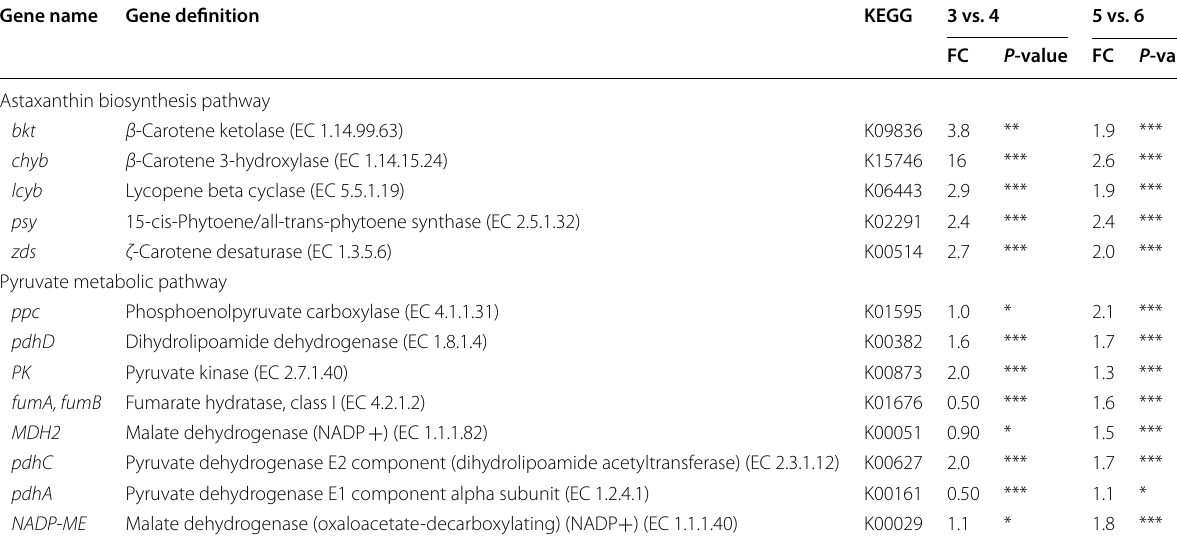
*** indicates statistical significance at P -value